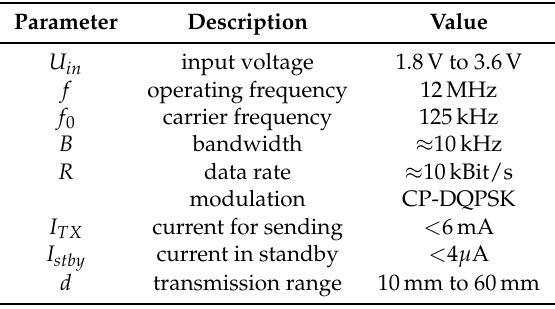
Table 2. Transmission parameters of the Implantable Infusion Pump